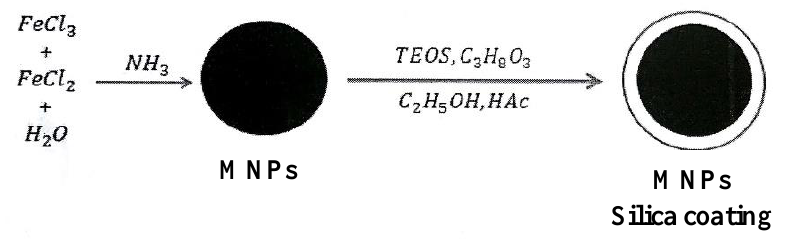
Figure 1. Schematic illustration of preparation of MNPs with silica coating.